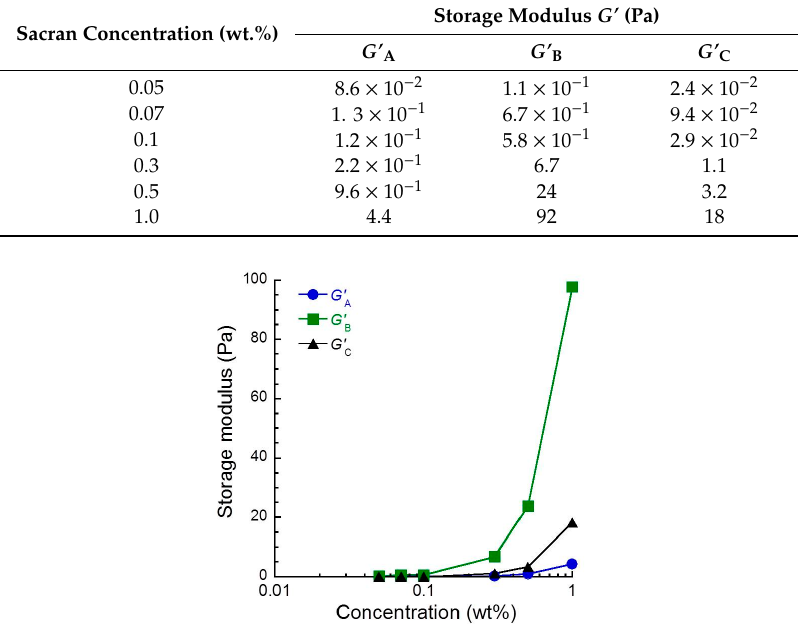
Figure 6. Effect of the low shear on the storage modulus for sacran aqueous solutions as a function of sacran concentrations.